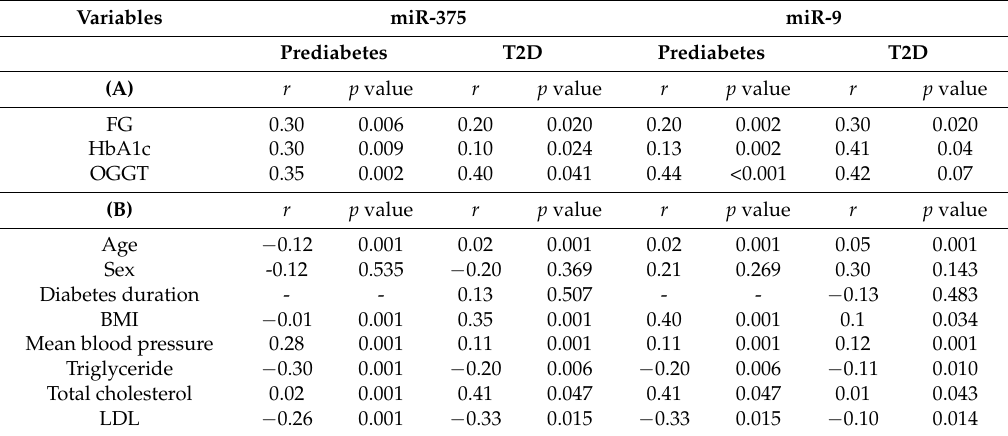
Table 4. ( A ) Correlation between miR-375 and miR-9 with glycemic status. ( B ) Correlation between miR-375 and miR-9 with other clinical